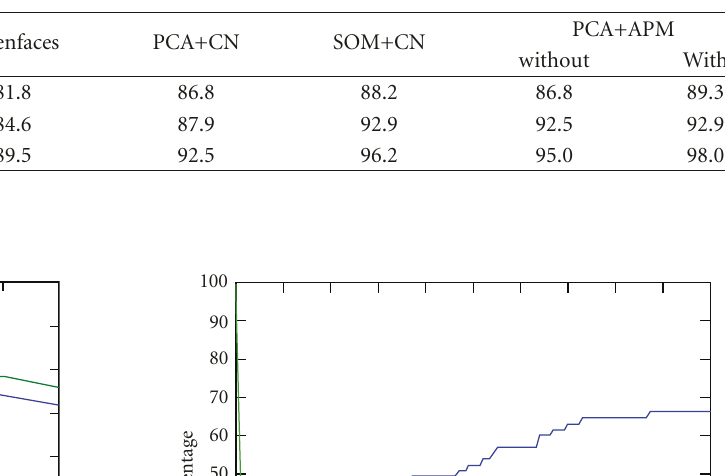
Table 3: The comparison of detection rates of the proposed method and others.